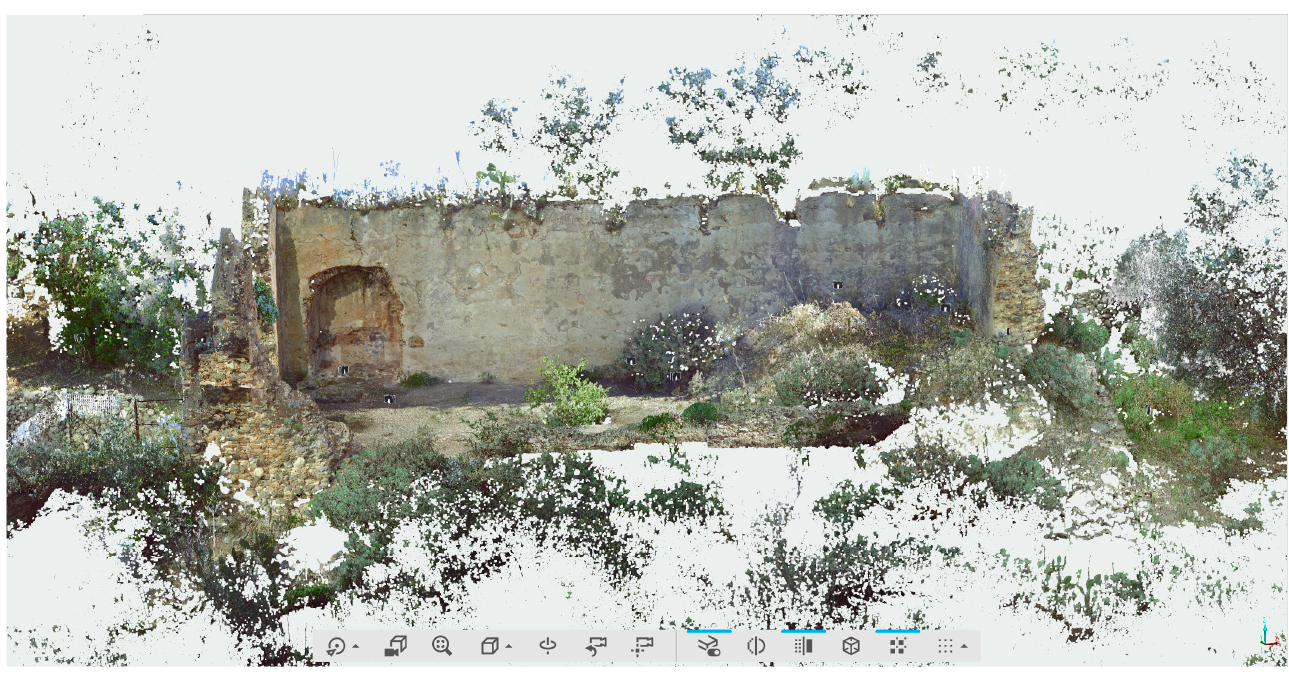
Figure 11. Church of San Nicola: RGB point cloud after registering.